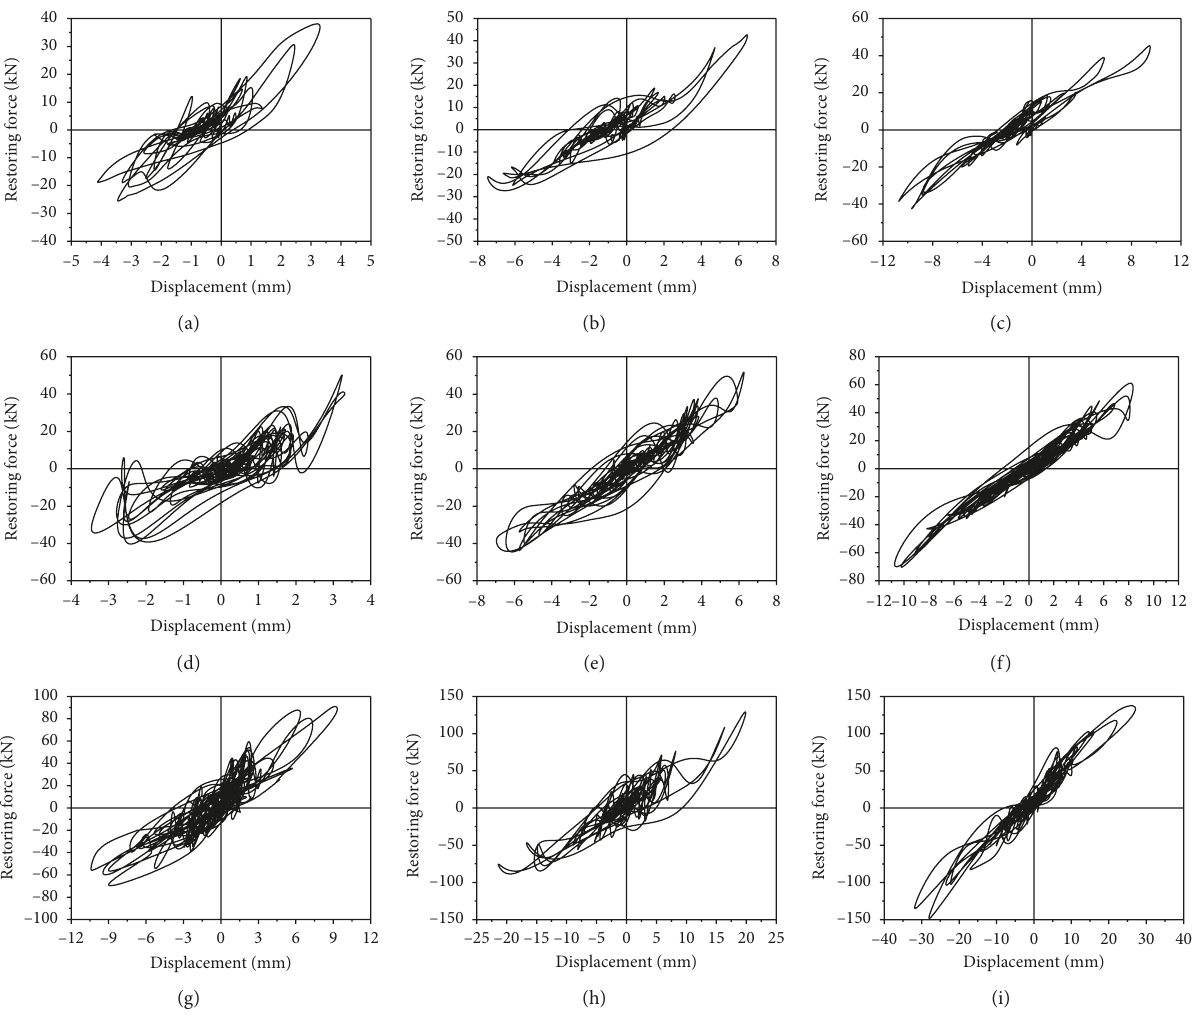
Figure 7: Restoring force characteristic curves of the prestressed fabricated concrete frame. (a) PGA � 2 × 34gal (first layer). (b) PGA � 2 × 34gal (second layer). (c) PGA � 2 × 34gal (third layer). (d) PGA � 3 × 34gal (first layer). (e) PGA � 3 × 34gal (second layer). (f) PGA � 3 × 34gal (third layer). (g) PGA � 6 × 34gal (first layer). (h) PGA � 6 × 34gal (second layer). (i) PGA � 6 × 34 gal (third